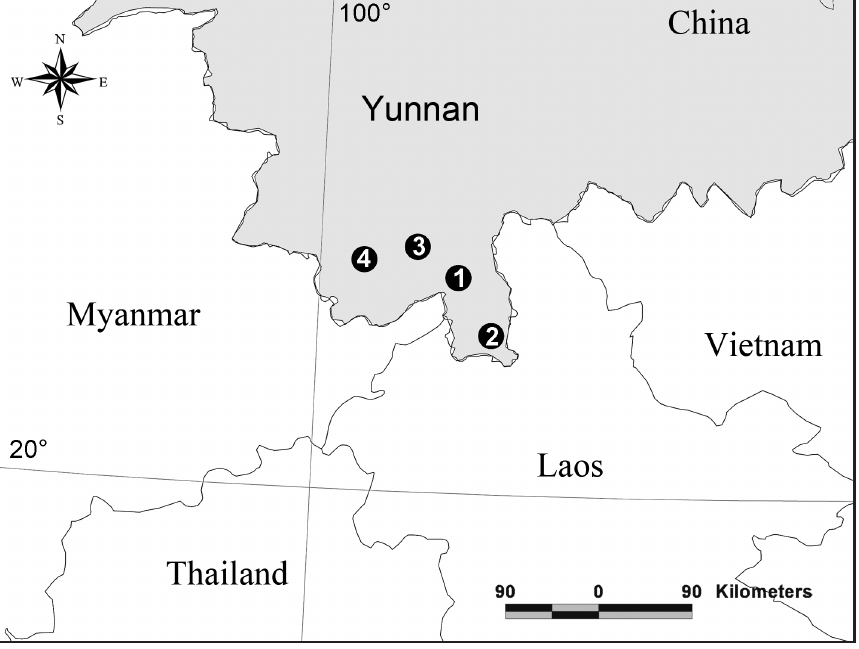
Figure 43. Four main collection localities in Xishuangbanna, Yunnan, China. 1 Mengla Town 2 Menglun Town 3 Mengyang Town 4 Menghai Town.